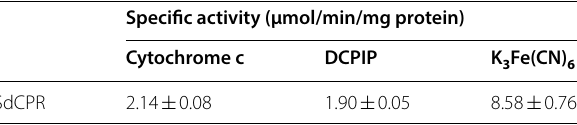
Fe(CN) , and DCPIP 3 6